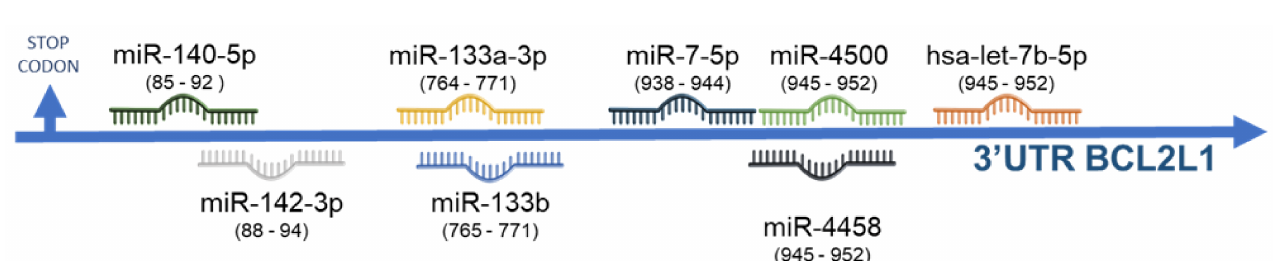
Figure 10. Scheme of microRNAs capable of regulating BCL-xL. Predictive analysis. Schematic representation of a bioinformatic prediction of microRNAs involved in the regulation of BCL2L1 by union to 3 (cid:48)